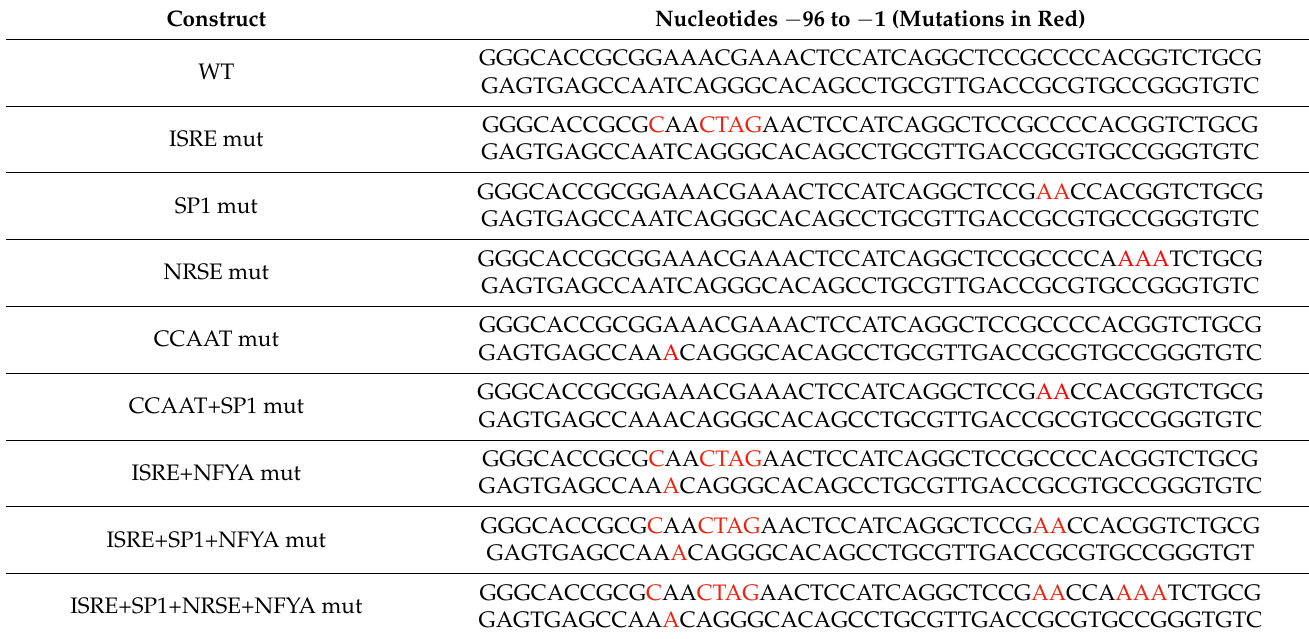
Table 1. Wild-type and mutant sequences within nucleotides − 96 to − 1 of the PNPT1 promoter region used in this study. Mutated nucleotides are shown in